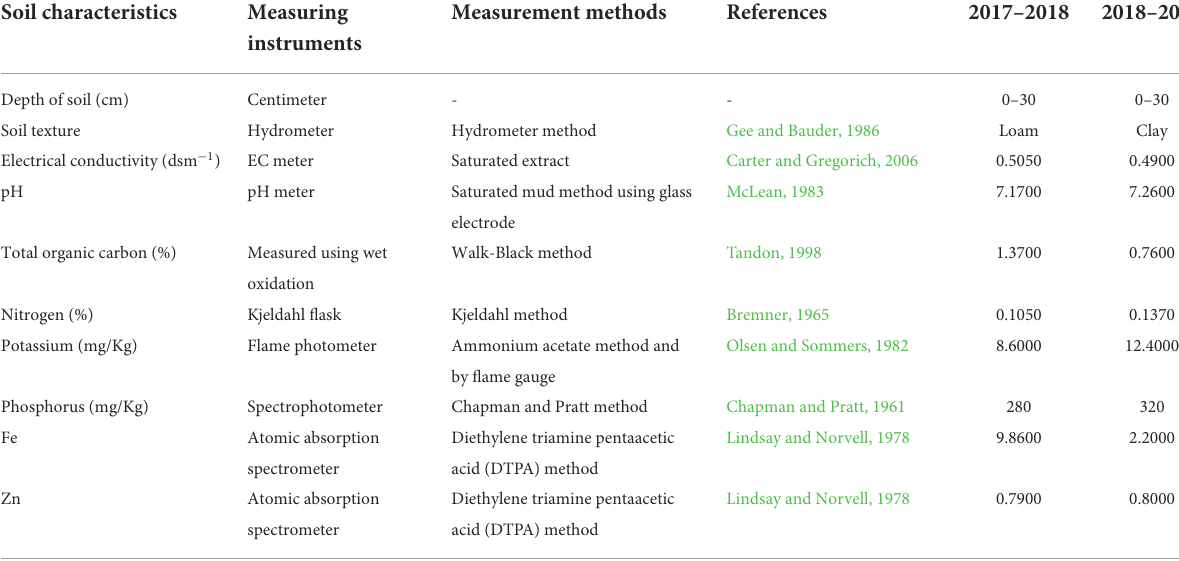
TABLE 1 Physicochemical properties of soil before planting in 2 years of experiment.